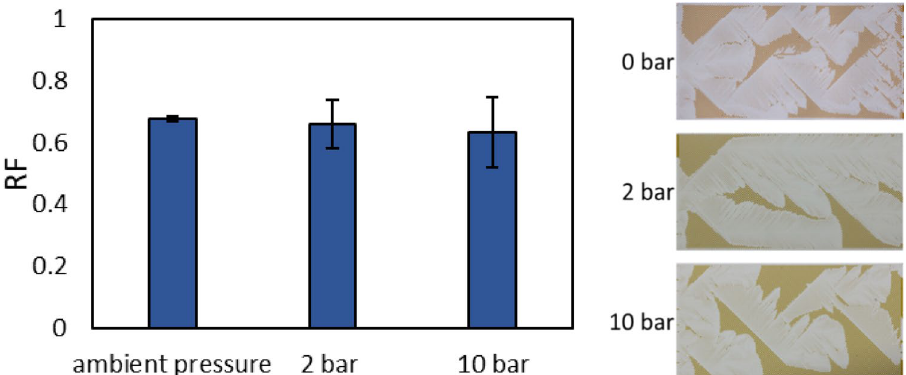
Figure 1. Recovery factors and patterns for crude oil A displaced by HS-Na at room temperature and different pressures (gauge). The change in color is due to different